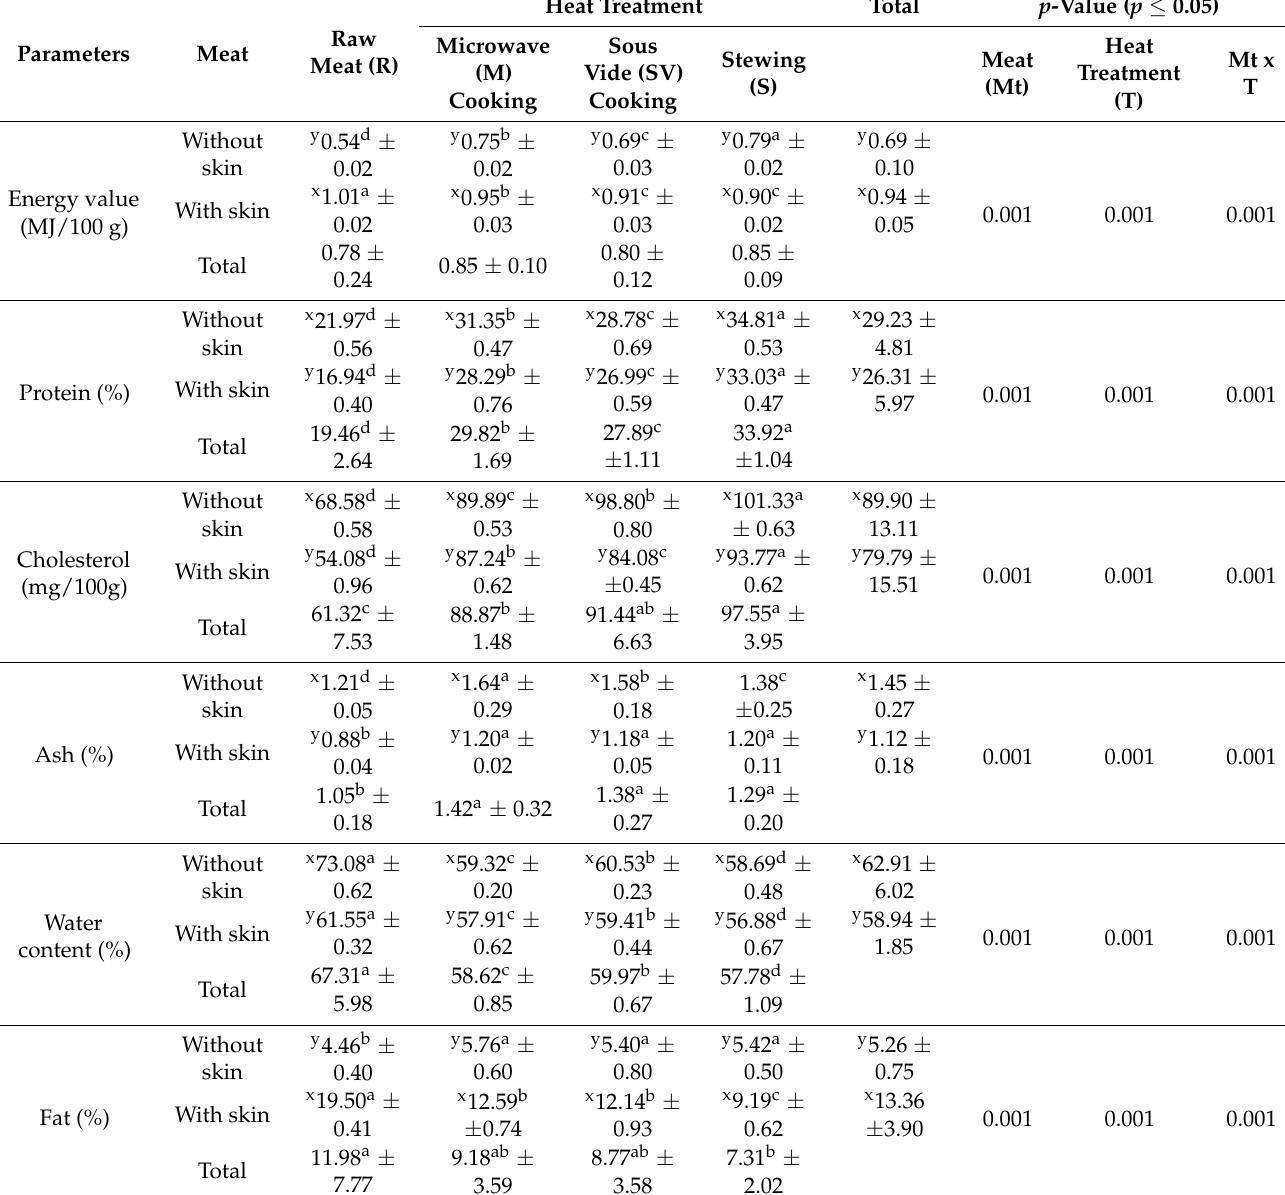
Table 1. Basic chemical composition, energy value, and total cholesterol content in raw and cooked goose meat (n = 6 breast muscles with skin and n = 6 without skin for each kind of heat